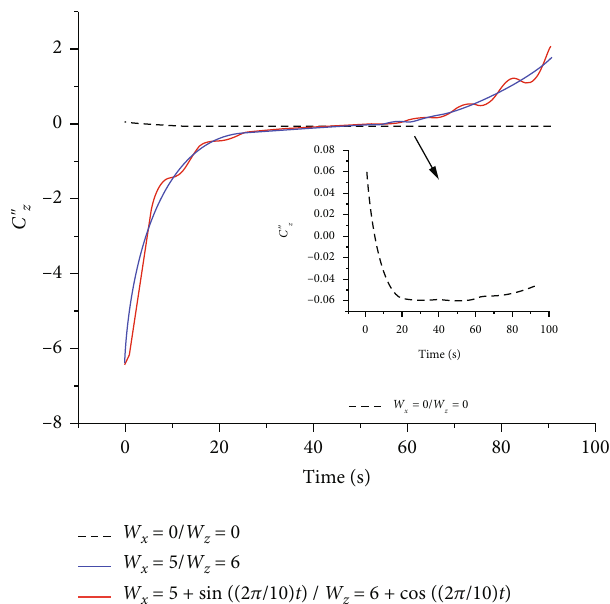
Figure 6: Variation curve of the joint partial derivatives of the Magnus force coe ffi cient under three